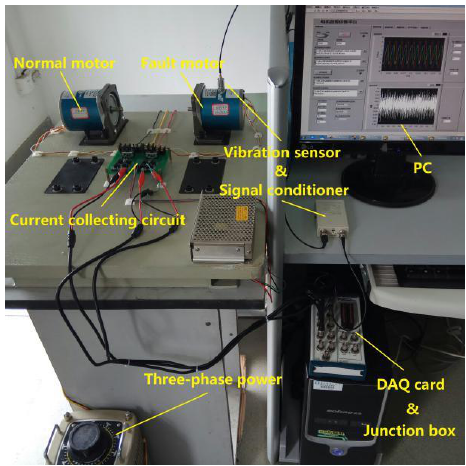
Figure 3. The experimental platform for PMSM fault detection.